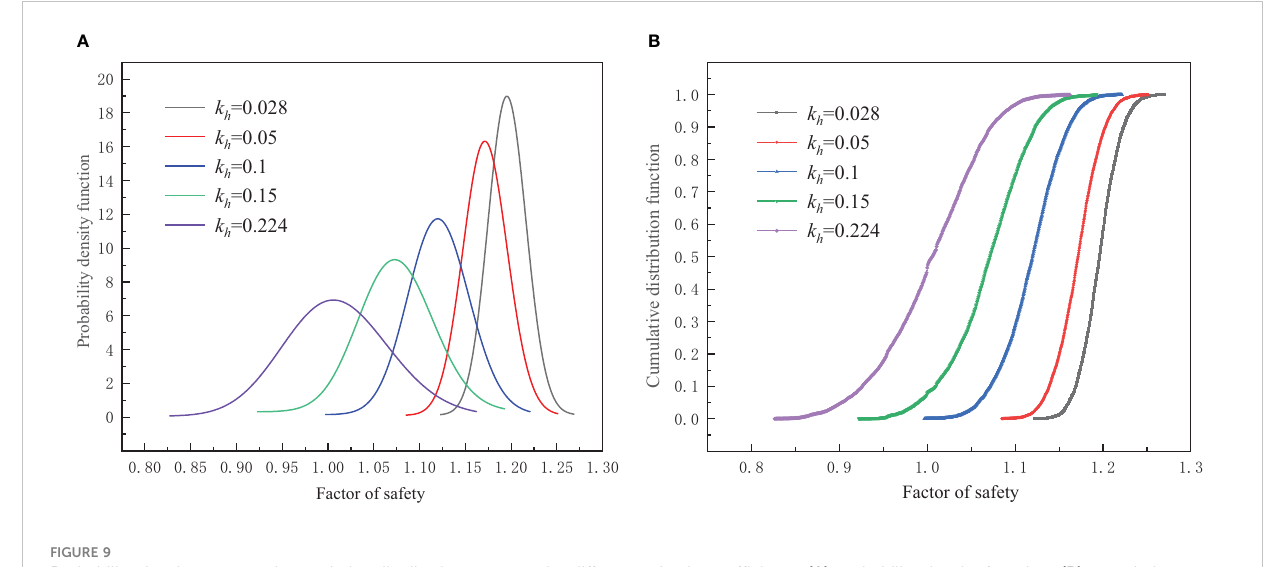
FIGURE 9 Probability density curve and cumulative distribution curve under different seismic coef fi cients: (A) probability density function; (B) cumulative distribution